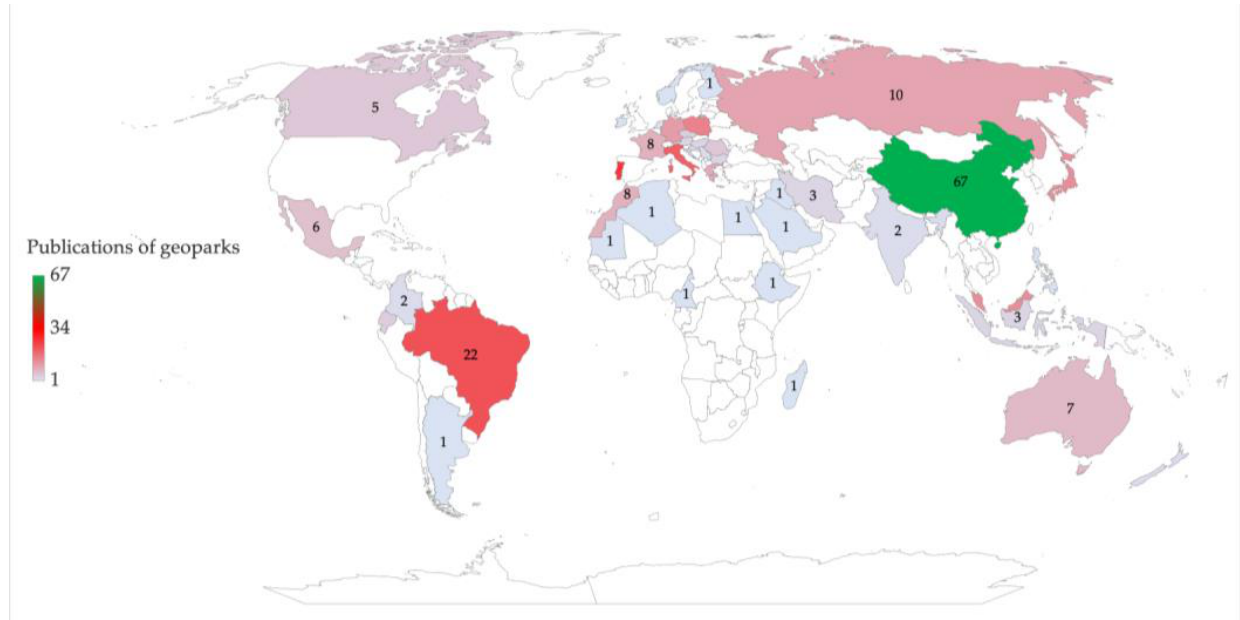
Figure 3. The number of publications by country. Source: own elaboration.